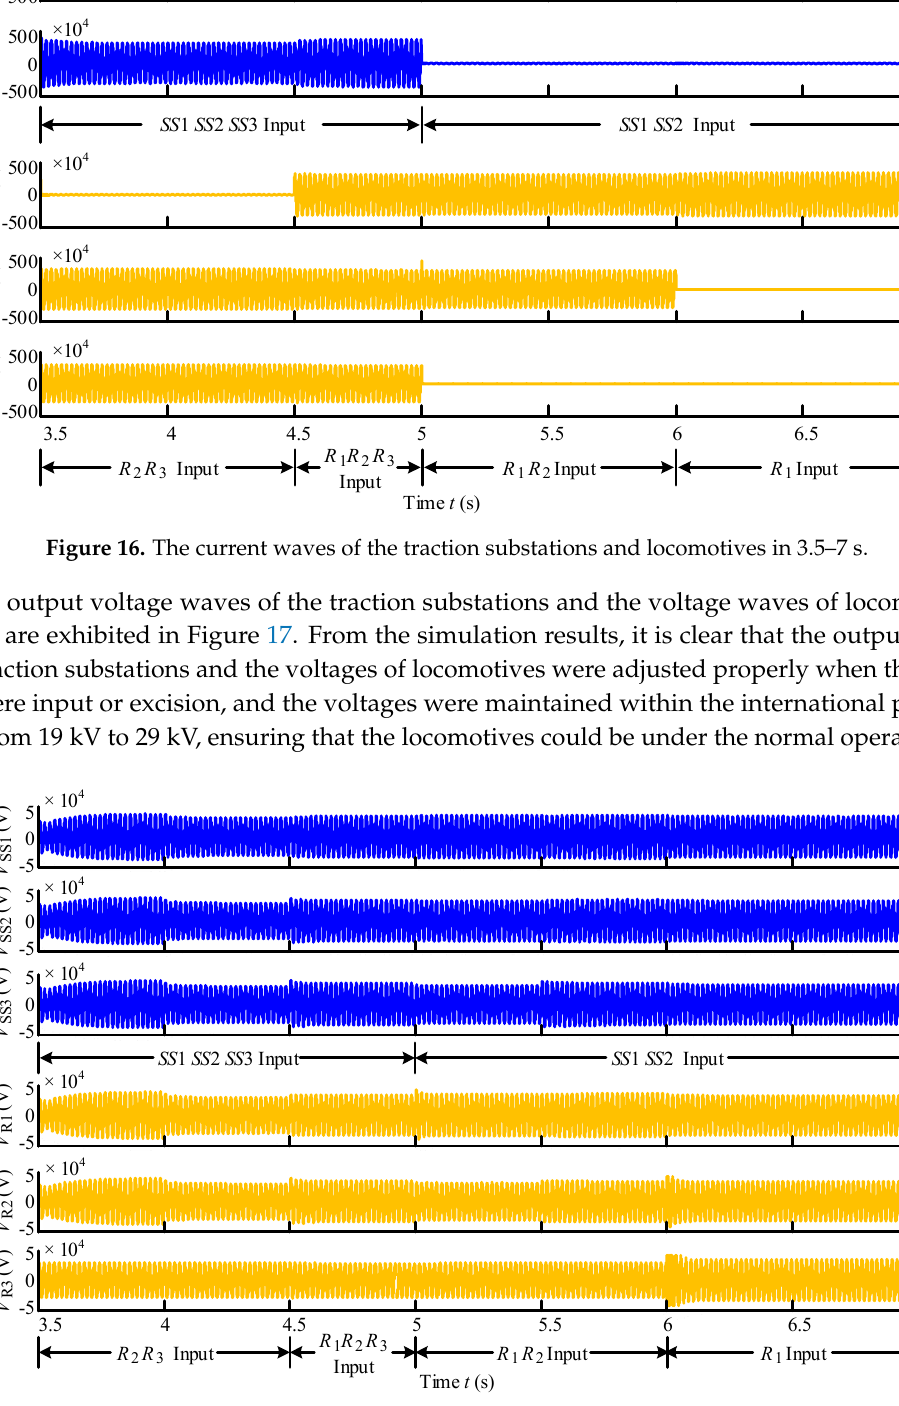
Figure 17. The voltage waves of the traction substations and locomotives in 3.5 ‒ 7 s.